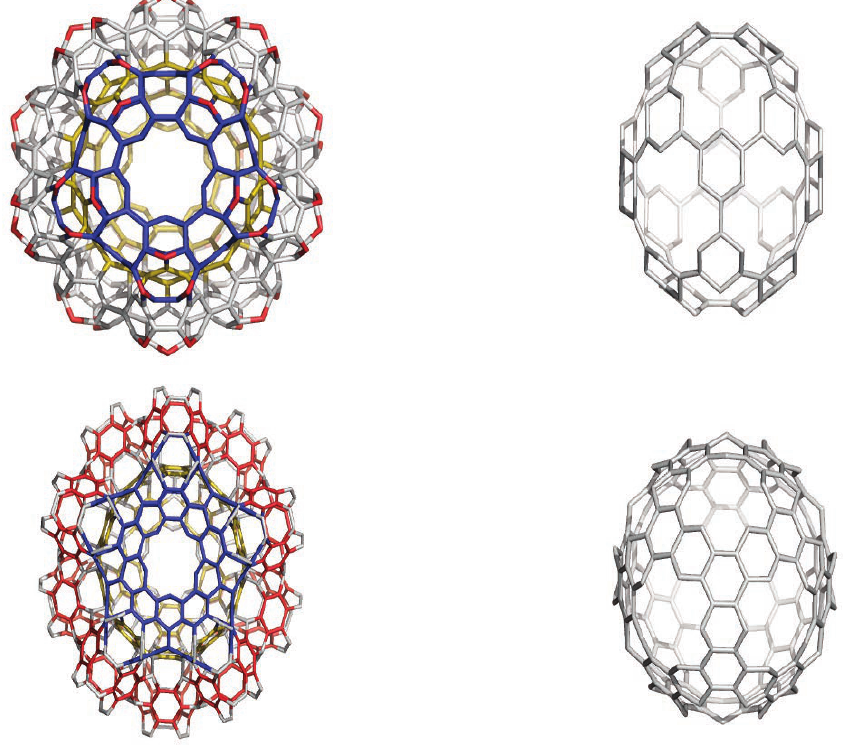
Figure 4. Top row: multi torus BTZ20_1_480 (left) and its core_120 (right). Bottom row: multi torus BTA20_1_780 (left) and its core_180 (right) .